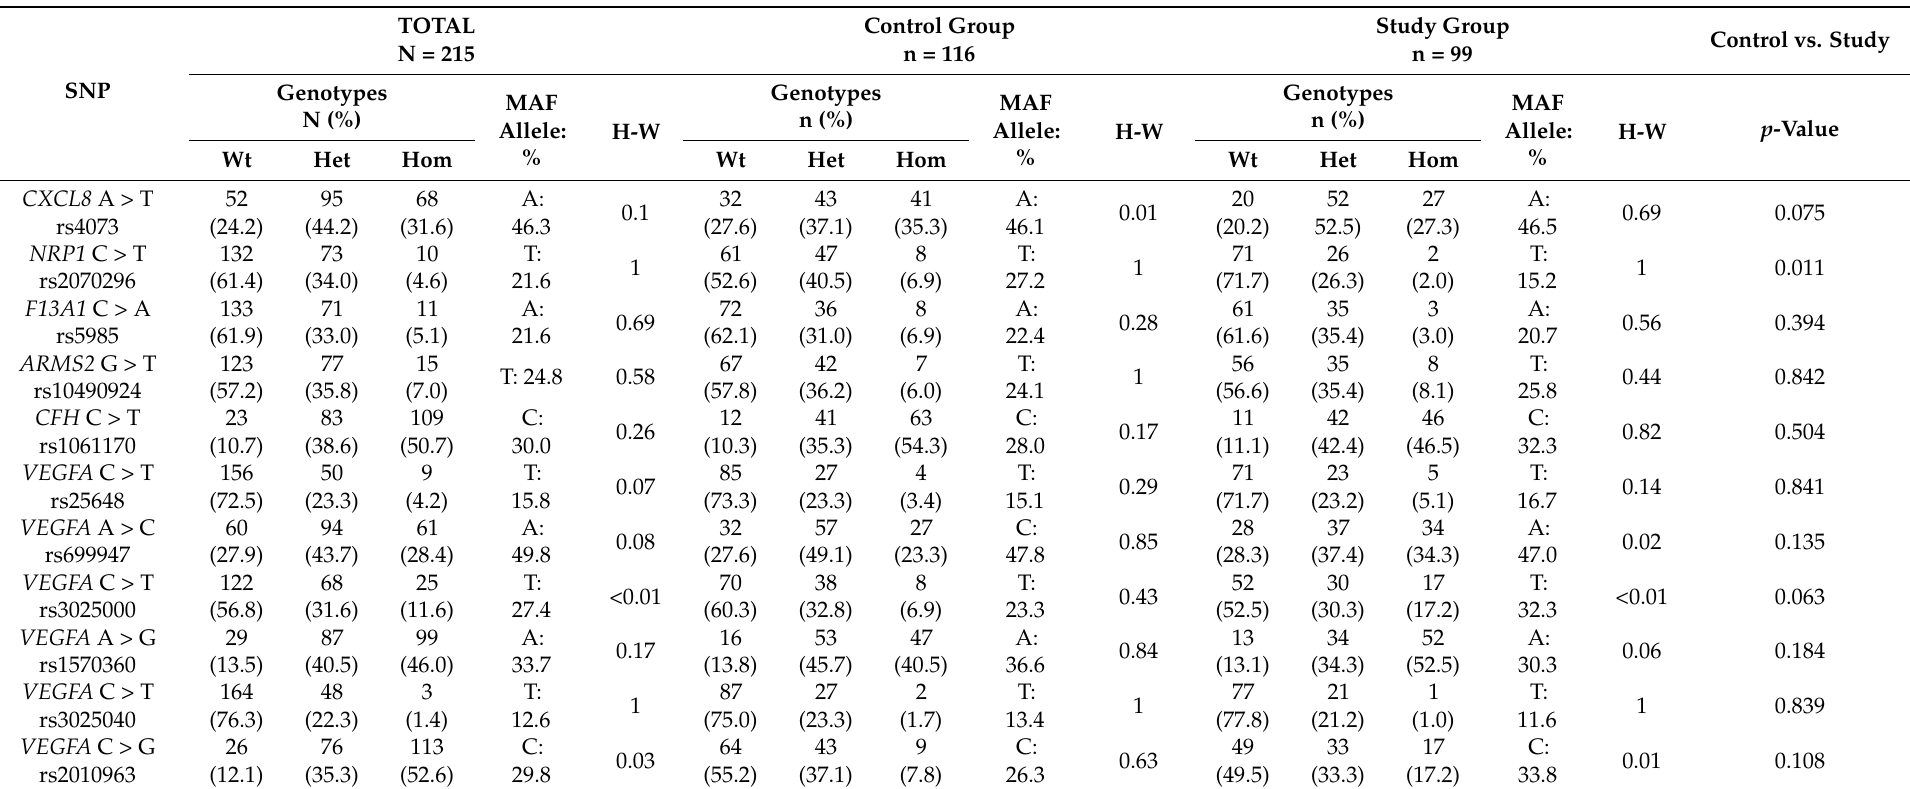
Table 3. Genotype distribution, minor allele frequency and Hardy-Weinberg equilibrium analysis for each studied SNP in our populationequilibrium, thus being candidates to influencing ranibizumab response; while CXCL8 (rs4073), NRP1 (rs2070296) and VEGFA (rs3025000, rs25648, rs699947, rs1570360, rs2010963) variants, have shown differences in this regard.